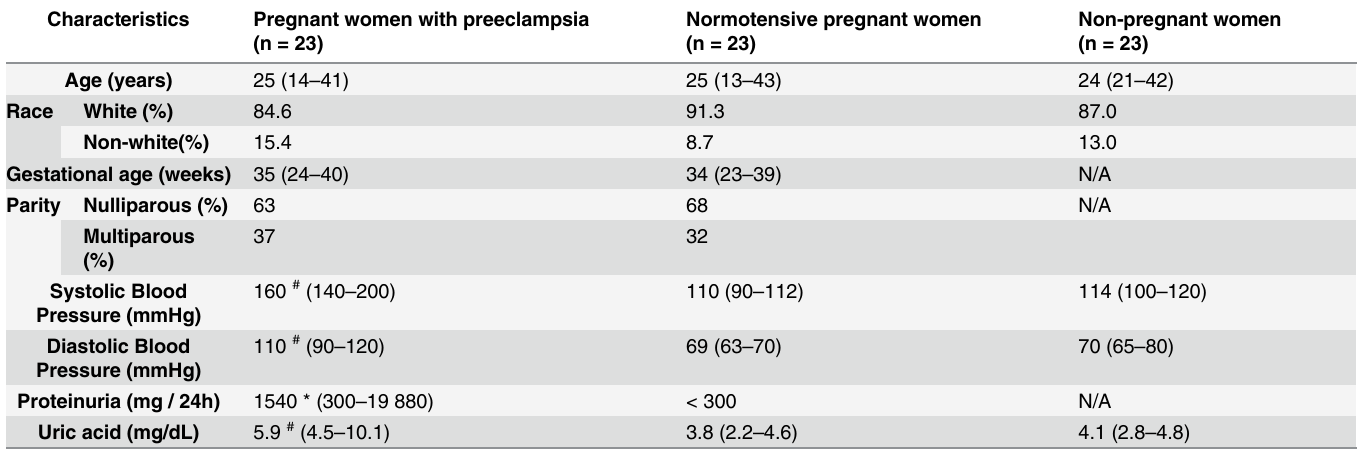
Table 2. Demographic and clinical characteristics of pregnant women with preeclampsia, normotensive pregnant women and non-pregnant women.